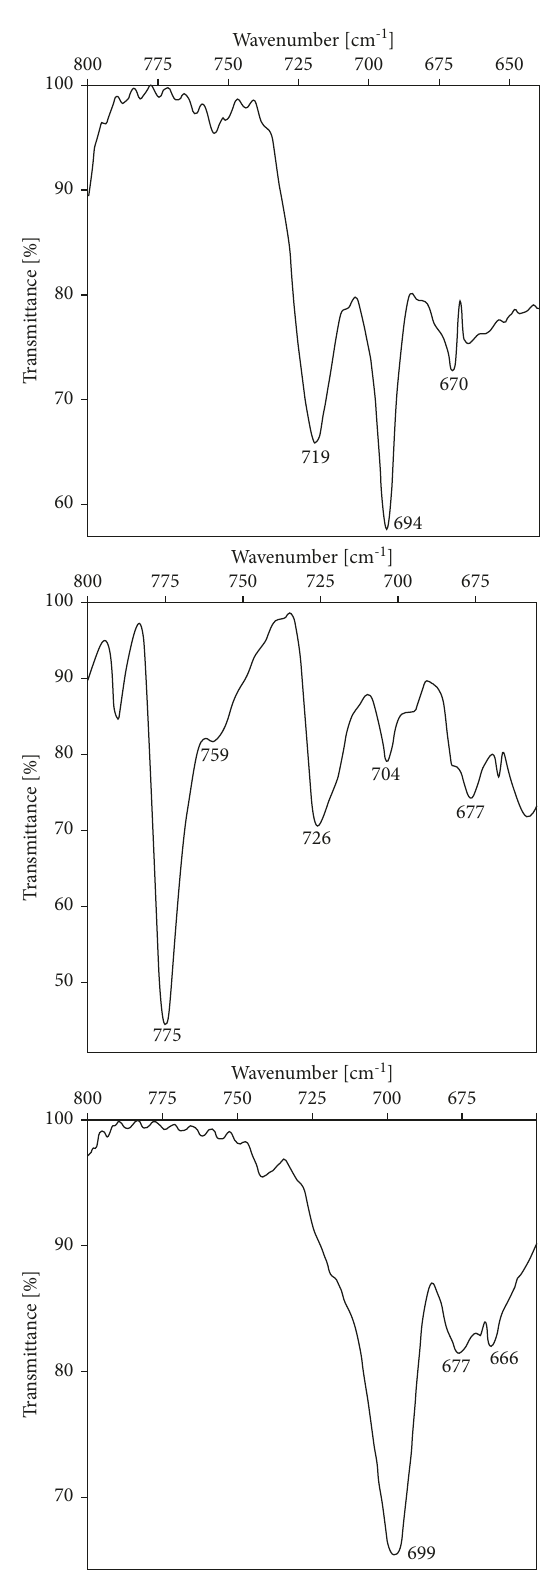
Figure 2: Fragmentary IR spectra in the solid state for infrared active secondary amides 2 and 4 with reference to 8 (in order from the top). The model, which took into account the out-of-plane N-H wagging provided a blue shift. The shift of the vibration bands varies between several tens of wavenumbers. The blue shift vibrational frequencies have proved to be a very sensitive indicator of the strength of the intramolecular